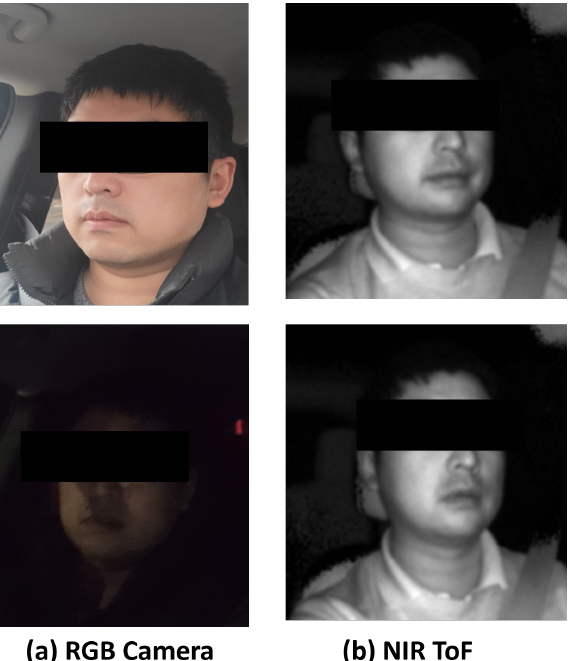
Figure 6. The user’s face seen by an RGB camera ( a ) in both bright ( top ) and dark ( bottom ) conditions versus the user’s face seen by the ToF camera in both bright ( top ) and dark ( bottom ) conditions. In both bright and dark environments, the images seen by the ToF camera are very similar, and HR can be extracted in both cases (Figure